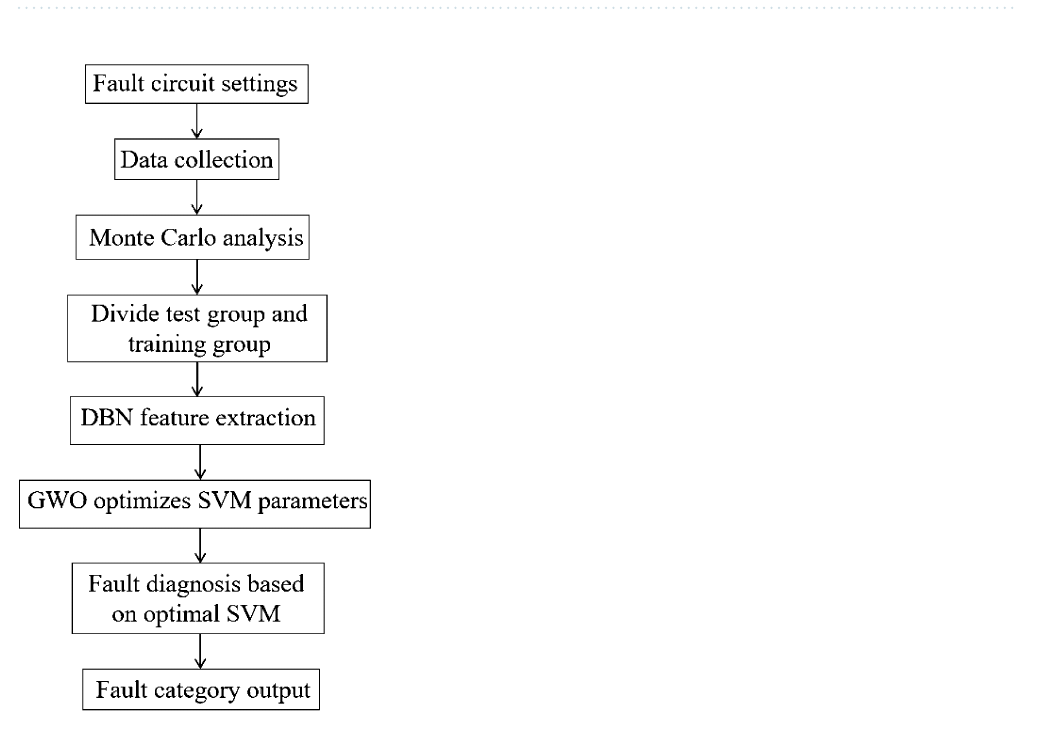
Table 2. Fault mode and fault value of four-op-amp biquad highpass filter circuit.